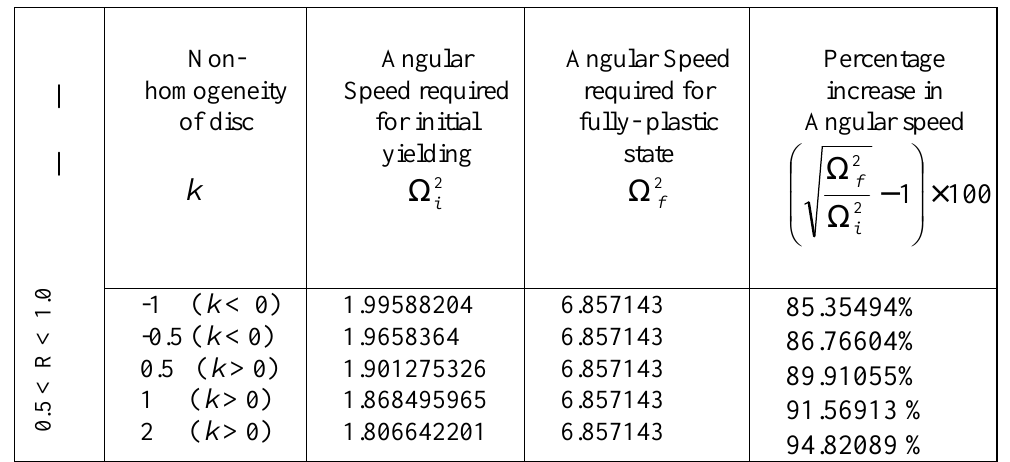
Angular Speed required for fully-